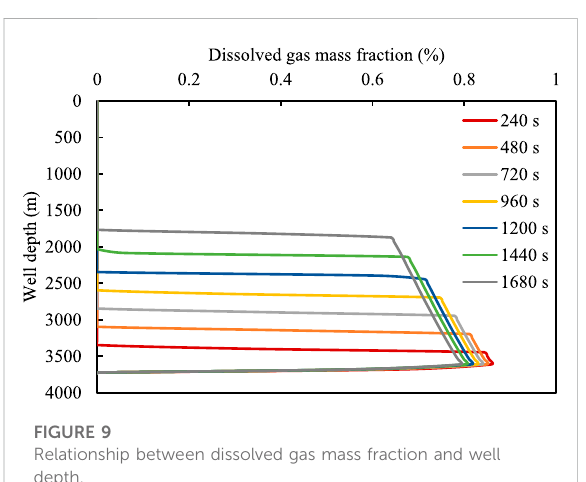
FIGURE 9 Relationship between dissolved gas mass fraction and well depth.